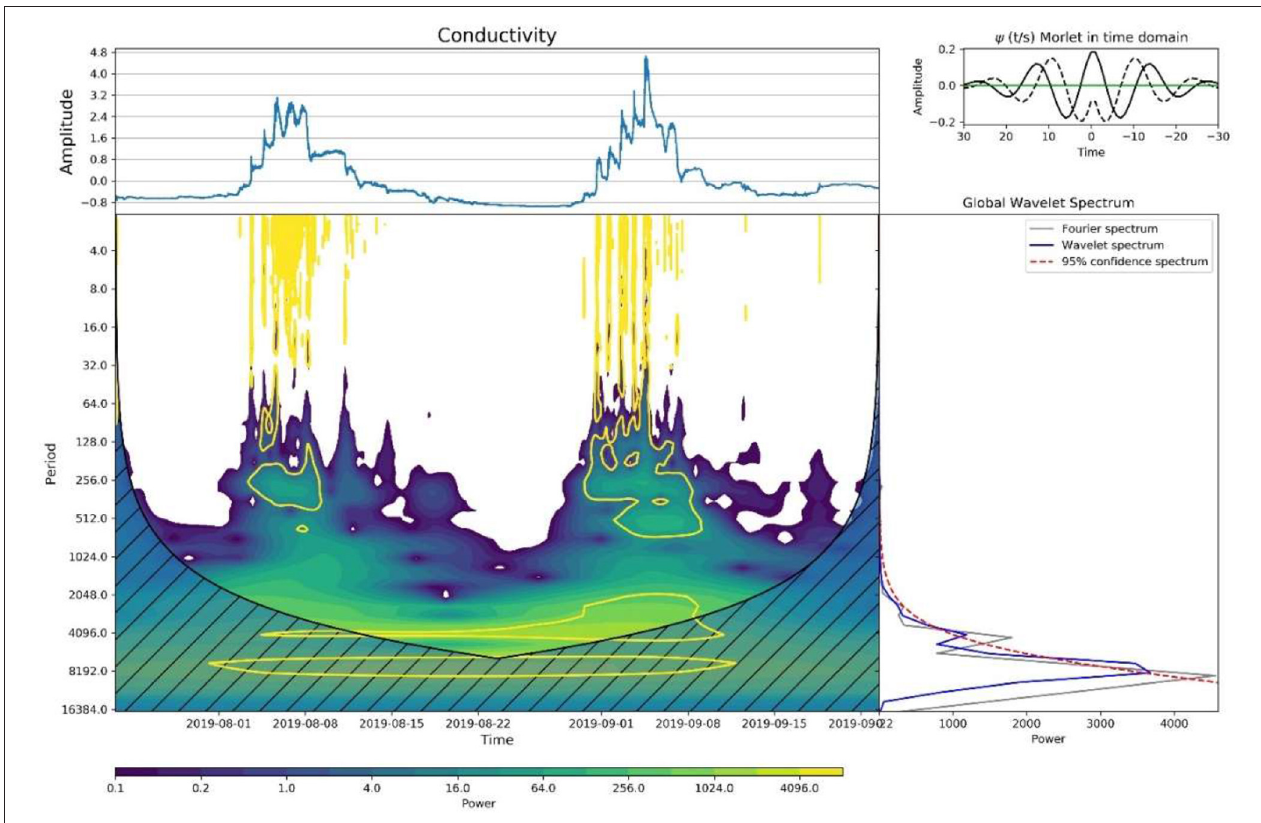
FIGURE 5 | Wavelet analysis –